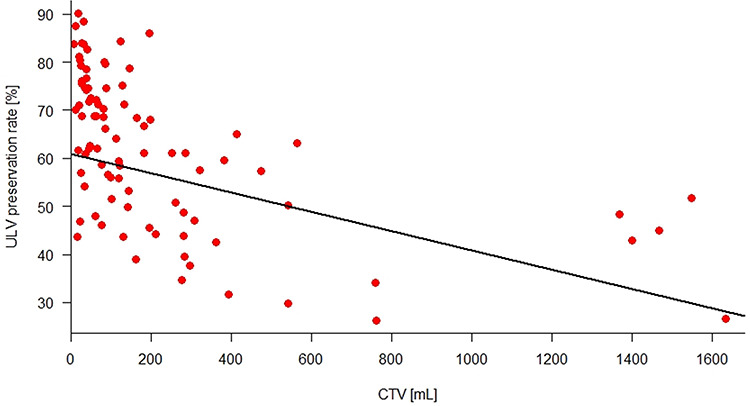
The scatter diagram to demonstrate the correlation between ULV preservation rate and CTV with regression line (straight black line). The baseline of the ULV preservation rate is 60.85%, decreasing 0.02% with each milliliter of CTV increase and adjusted by the tumor location and PVTT status.